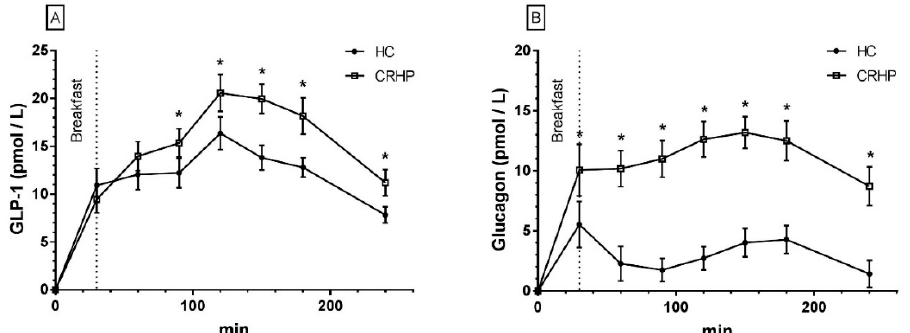
Figure 4. Mean ± SEM 4-h concentrations of GLP-1 ( A ) and glucagon ( B ) in 14 non-diabetic subjects after intake of a CRHP or HC breakfast, respectively (mean of 2 consecutive days on each diet). * Significant difference ( p < 0.05) between the HC and CRHP diet. HC: high carbohydrate; CRHP: carbohydrate-reduced high-protein; GLP-1: glucagon-like peptide-1.